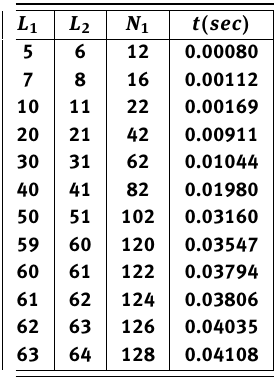
Table 3. Numerical results for the verification of one is 1